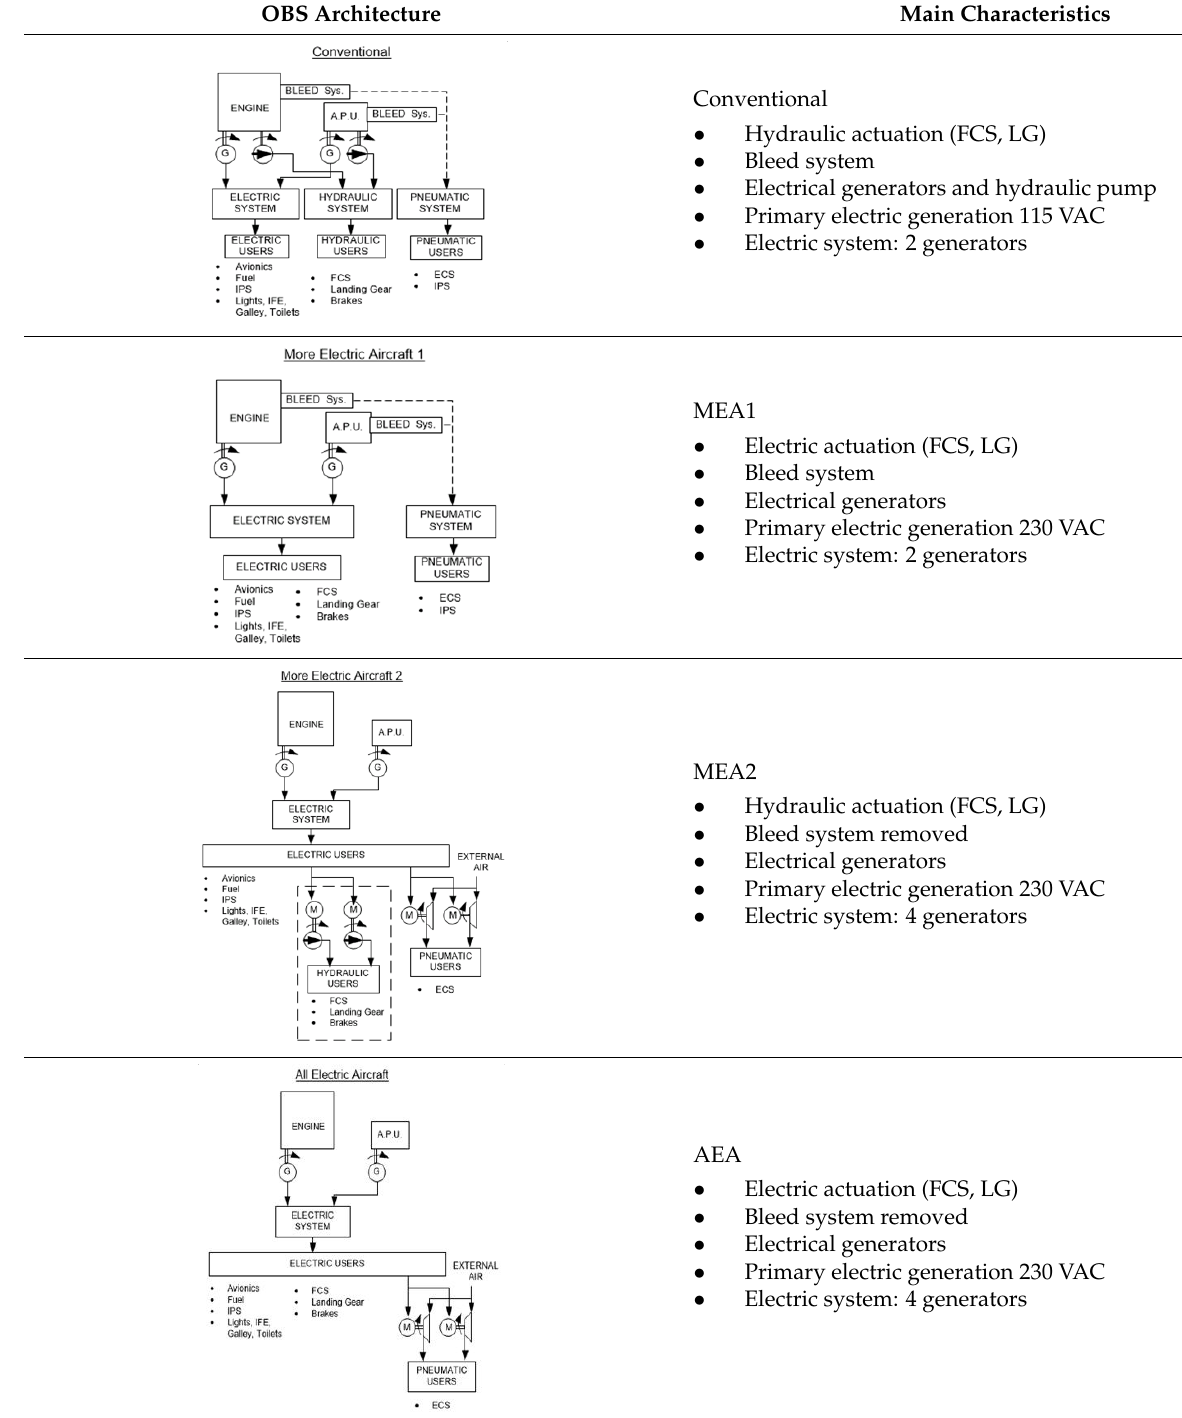
Table 2. Main characteristics of the architecture considered for OBS electrification. OBS Architecture